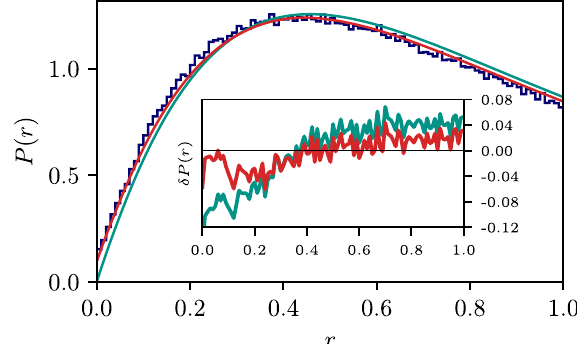
FIG. 6. Probability distribution of the gap ratio from the Heisenberg model of Eq. (63) with L ¼ 18 spins, with periodic boundary conditions. Data are averaged over all realizations of 1 = 2 ( 2 18 in total, 3914 of which the binary transverse field h j ¼ (cid:5) are nonequivalent up to symmetries) and over 150 eigenstates E = 2 . The around infinite temperature energy E ¼ ð E min þ max Þ red solid line represents the analytical prediction, Eq. (64): a r Þ obtained from the linear combination of surmises P GOE m ð analytical computations in Sec. III. For comparison, the green solid line shows the predicted distribution when two block contributions are not taken into account. Inset: difference δ P ð r Þ between the numerical data and these